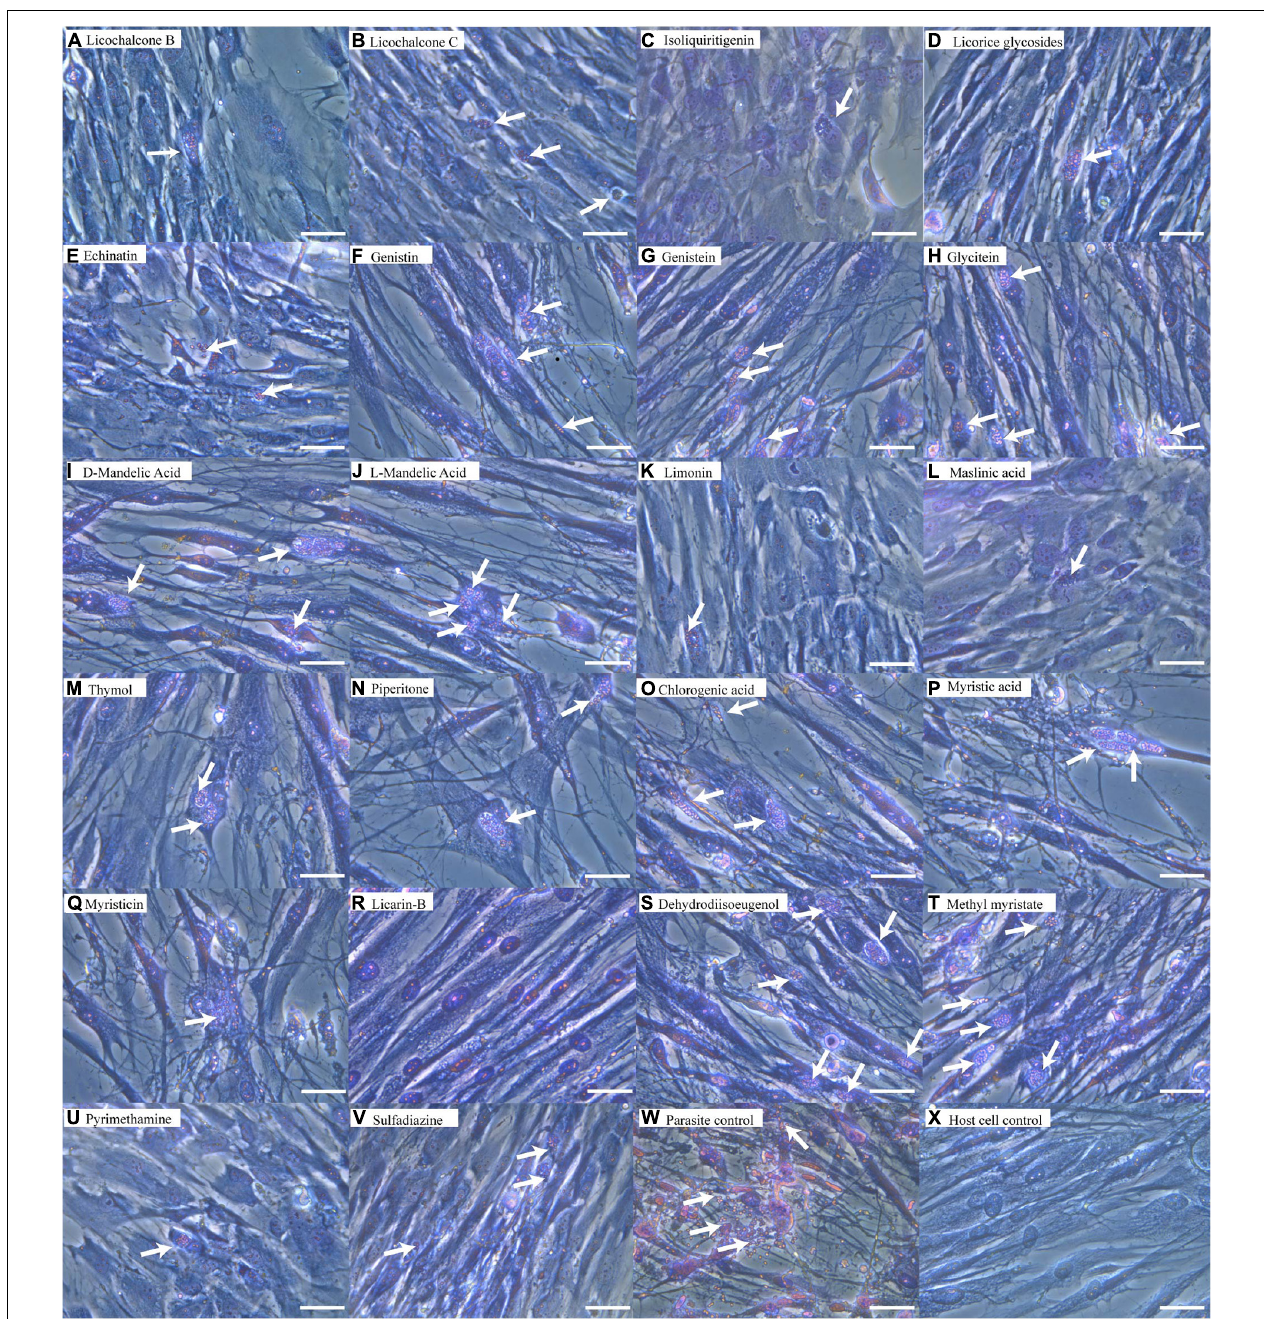
FIGURE 1 | Anti- T. gondii activity of natural compounds as determined by Giemsa staining. HFFs were infected with T. gondii tachyzoites for 8 h and incubated with compounds in DMEM supplemented with 1% FBS for 24 h. The cells were washed twice with PBS, stained with Giemsa, and observed by light microscopy. Licochalcone B (A) , Licochalcone C (B) , Isoliquiritigenin (C) , Licorice glycosides (D) , Echinatin (E) , Genistin (F) , Genistein (G) , Glycitein (H) , D-mandelic acid (I) , L-mandelic acid (J) , Limonin (K) , Maslinic acid (L) , Thymol (M) , Piperitone (N) and Chlorogenic acid (O) , Myristic acid (P) , Myristicin (Q) , Licarin-B (R) , Dehydrodiisoeugenol (S) , Methyl myristate (T) , Pyrimethamine (U) , Sulfadiazine (V) , Parasite control (W) , Host cell control (X) . The arrows indicated parasitophorous vacuoles (PVs) and tachyzoites in the host cells. Scale bars: 50 µ m.